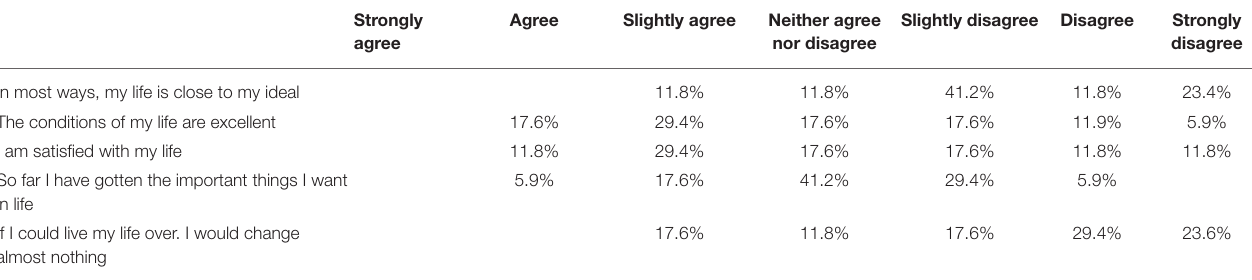
TABLE 1 | Assessment of life satisfaction of the respondents assessed using the SWLS scale.